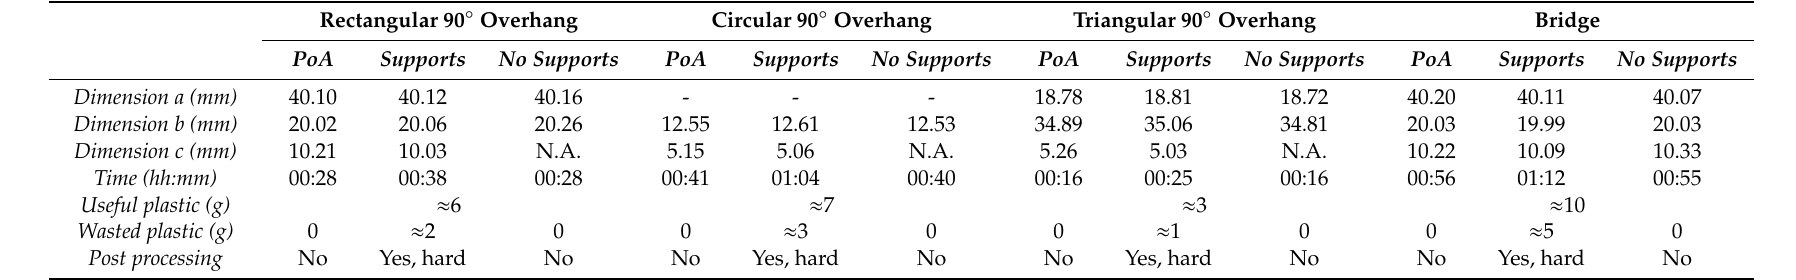
Table 1. Measurement results for the four di ff erent printed